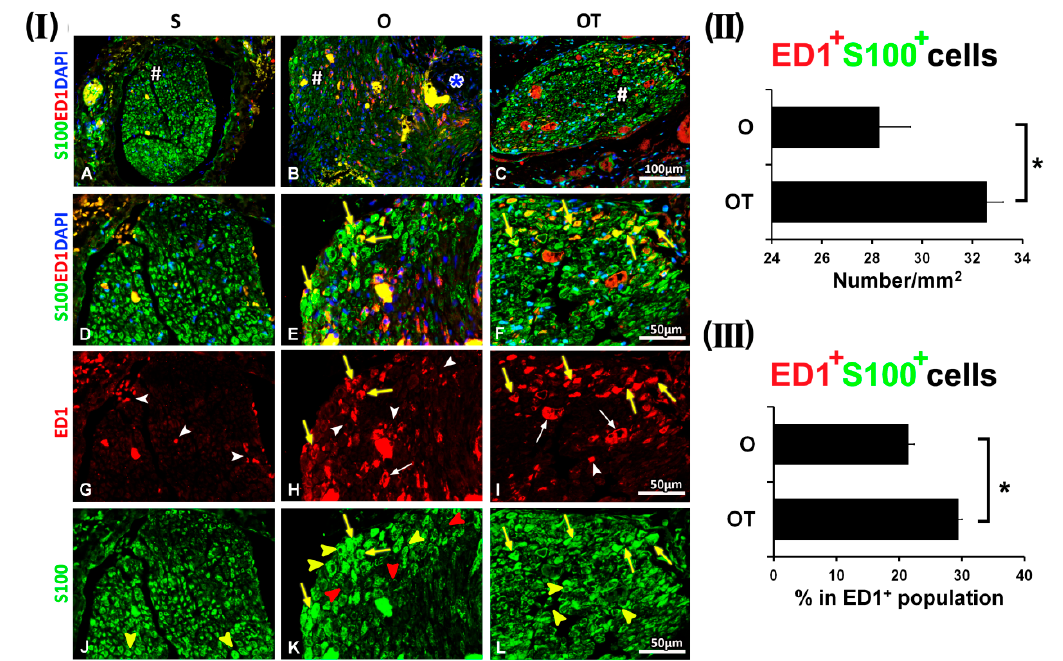
Figure 2. Effect of PNI and the treatment with B vitamins on SCs-macrophages co-localization at the 3rd dpo. ( I ) Cross sections of the femoral nerve obtained from the sham (S), operated (O, the transection of the motor branch) and operated and treated with the vitamin B complex (B1, B2, B3, B5, B6, and B12) (OT) groups were stained for ED1 (red), a marker of activated macrophages, anti-S100 antibody (green) as a marker of SCs, and counterstained with DAPI (blue) for visualizing cell nuclei. In the S group, a paucity of ED1 + cells was detected ( G , white arrow heads), myelinating, mature SCs were the predominant cell type ( J , yellow arrow heads) and there was no overlapping of ED1 and S100 immunoreactivity ( A , D ). In the O and OT groups ED1 + / S100 + cells ( E and F , yellow arrows) were noticed, whereby ED1 + macrophages, closely associated to SCs, had “foamy” morphology of M2 type ( H and I , yellow arrows). In both groups, ED1 + macrophages with the “foamy” morphology ( H and I , white arrows), and SCs that were only S100 + ( K and L , yellow arrow heads) were noticed as well. In the O group some ED1 + macrophages of the M1 type morphology ( H , white arrow heads), were detected around faintly stained SCs ( K , red arrow heads). Blue asterisk marks the site of transection and immediate reconstruction by termino-terminal anastomosis, while # indicates where the high magnification micrographs were taken from. Scale bars: A – C = 100 µ m, D – L = 50 µ m. ( II ) The quantification of double positive ED1 + / S100 + cells from the O and OT experimental groups is depicted in the graphs (black bars) as a number of double positive cells / mm 2 and ( III ) the percentage of double positive cells in the ED1 + cells population. The data are shown as the mean ± SEM of three independent experiments (three images / group / independent experiment were captured). Statistical analysis was done using a two-sided Student’s t -test (* p < 0.05 vs. O group, as indicated at the graphs).